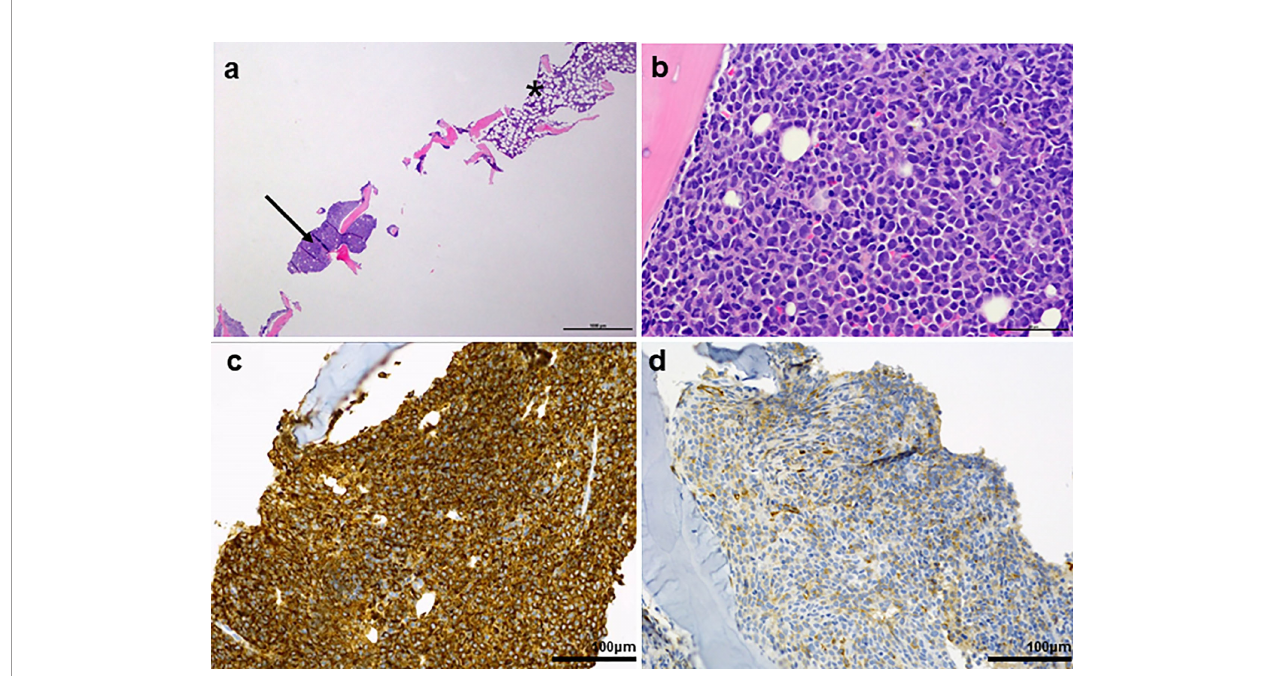
FIGURE 3 | (A) Overview of a bone marrow biopsy with discontinuous in fi ltration by acute promyelocytic leukemia (arrow: APL; *: areas with normal bone marrow. (B) Abnormal promyelocyctes show variable nuclear size and shape. Typical kidney shaped nuclei are visible. (C) Strong MPO reaction in all leukaemic promyelocyctes. (D) Partial and weak CD34